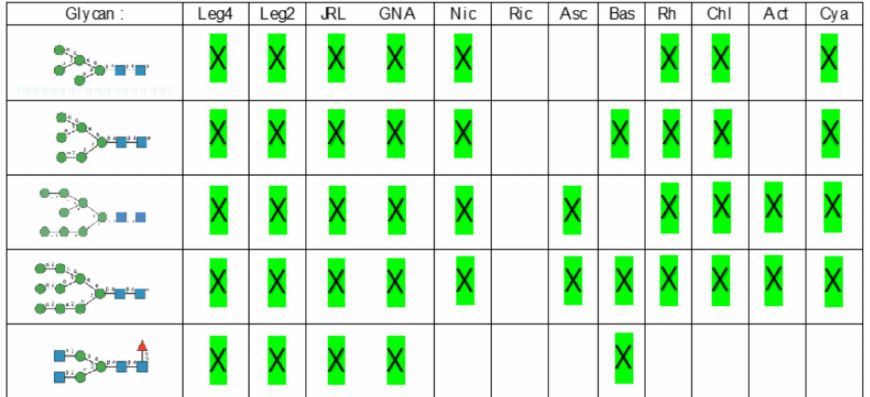
Figure 31. SARS-CoV glycans that can be recognized (X) by Man-specific lectins from plants, mush- rooms, algae, and cyanobacteria, as predicted from the results of glycan arrays performed with purified lectins: Leg4 (Con A): single-chain legume lectins; Leg2 (PsA, LcA): two-chain legume lectins; JRL (Morniga-M): jacalin-related lectins; GNA (GNA, ASA): GNA-like lectins; Nic: Nictaba from Nicotiana tabacum ; Ric: ricin-B from Ricinus communis ; Asc (NcCVN): lectins from Ascomycota; Bas (ABA): lectins from Basidiomycota; Rh (griffithsin, KAA-2): lectins from Rhodophyta; Chl (BCA): lectins from Chlorophyta; Act (actinohivin): lectins from actinomycetes; Cya (cyanovirin): lectins from cyanobacteria.